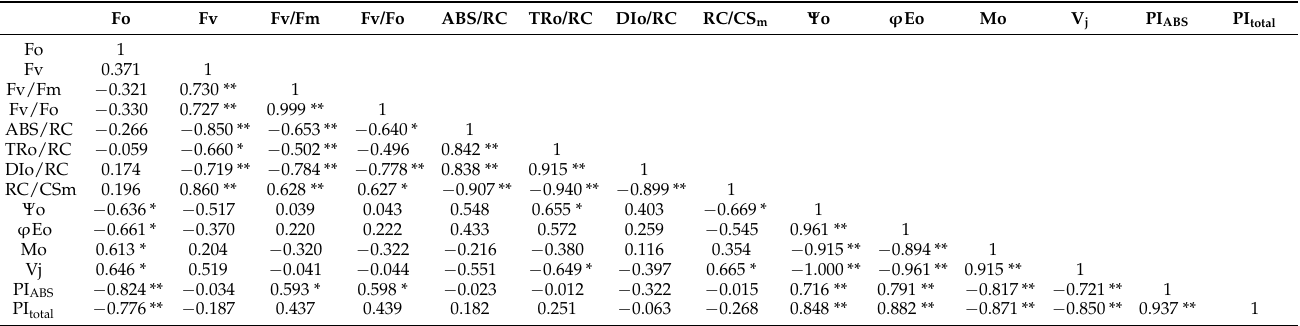
Table 6. Correlation of chlorophyll fluorescence parameters under high-temperature